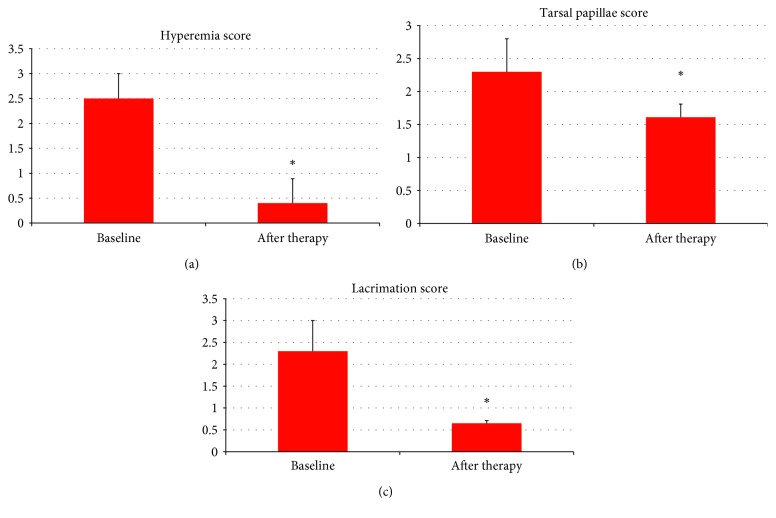
Some signs of pathology improvement 3 months after the start of CY (cyclosporine) therapy, such as: conjunctival hyperemia/chemosis, baseline 2.5 (±0.5 SD) score, and posttherapy 0.40 (±0.49 SD) score (p=0.001) (a); tarsal papillae, baseline 2.3 (±0.5 SD) score, and posttherapy 1.61 (±0.2) score (p=0.016) (b); and lacrimation, baseline 2.3 (±0.7 SD) score, and posttherapy 0.65 (±0.06 SD) score (p=0.045) (c).